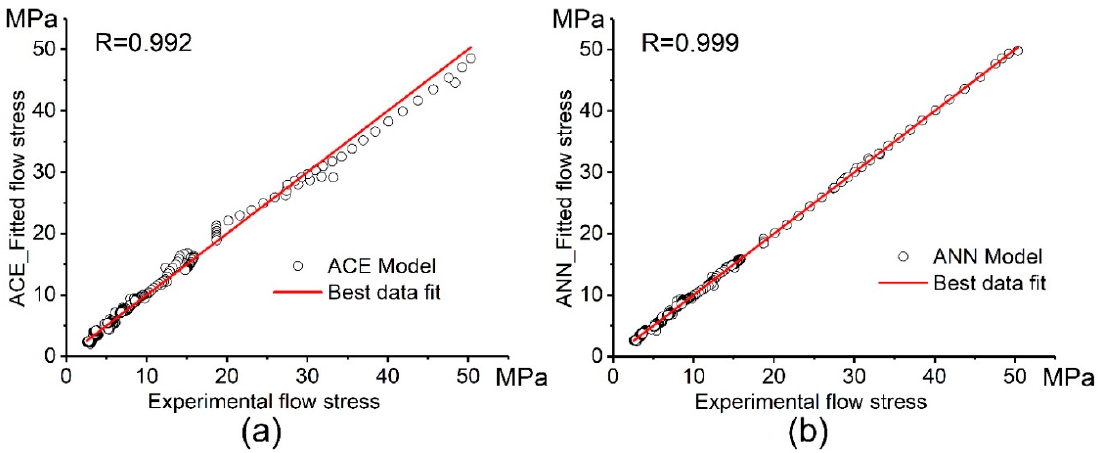
Figure 10. Correlation between the experimental and the modeled flow stress obtained by the ( a ) Constitutive model and ( b ) ANN model.